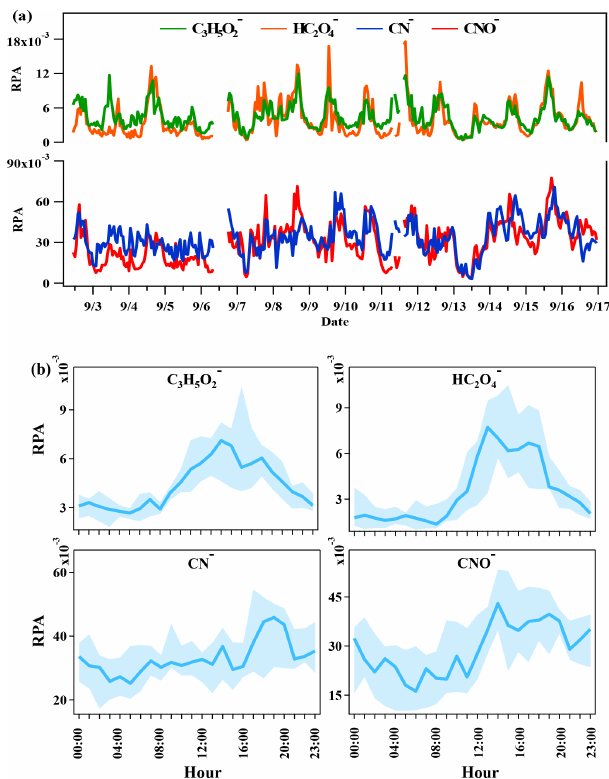
Figure 7. (a) Temporal trends of the relative peak areas (RPAs) of − 73 C , 89 HC 2 O − , 26 CN − , and 42 CNO − in DEA-containing 3 H 5 O 2 4 particles. (b) Diurnal variations in the RPAs of 73 C 3 H 5 O − , 2 − 89 HC , 26 CN − , and 42 CNO − in DEA-containing particles. 2 O 4 (cid:113) (cid:113) different volatilities of DEA HNO 3 and TMA HNO 3 on the formation of particulate amines in chamber experiments due to the lack of quantitative results in this